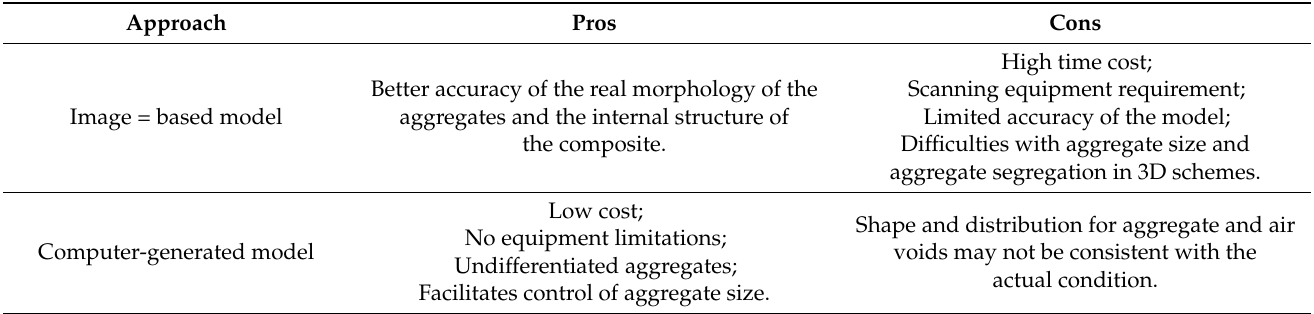
Table 6. Pros and cons of image-based and computer-generated